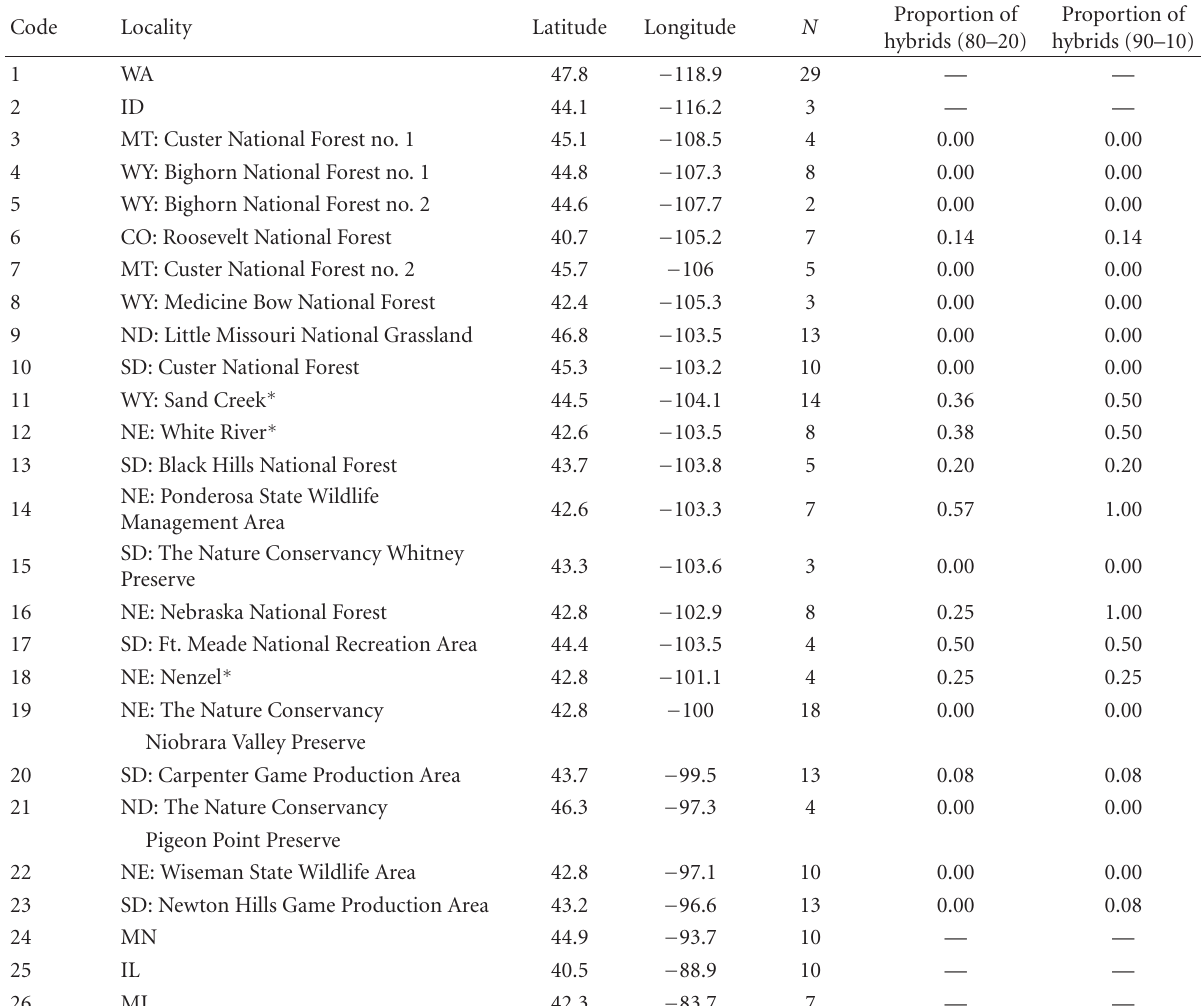
Table 1: Sampling localities, sample sizes, and the proportion of hybrid individuals for populations analyzed in this study.